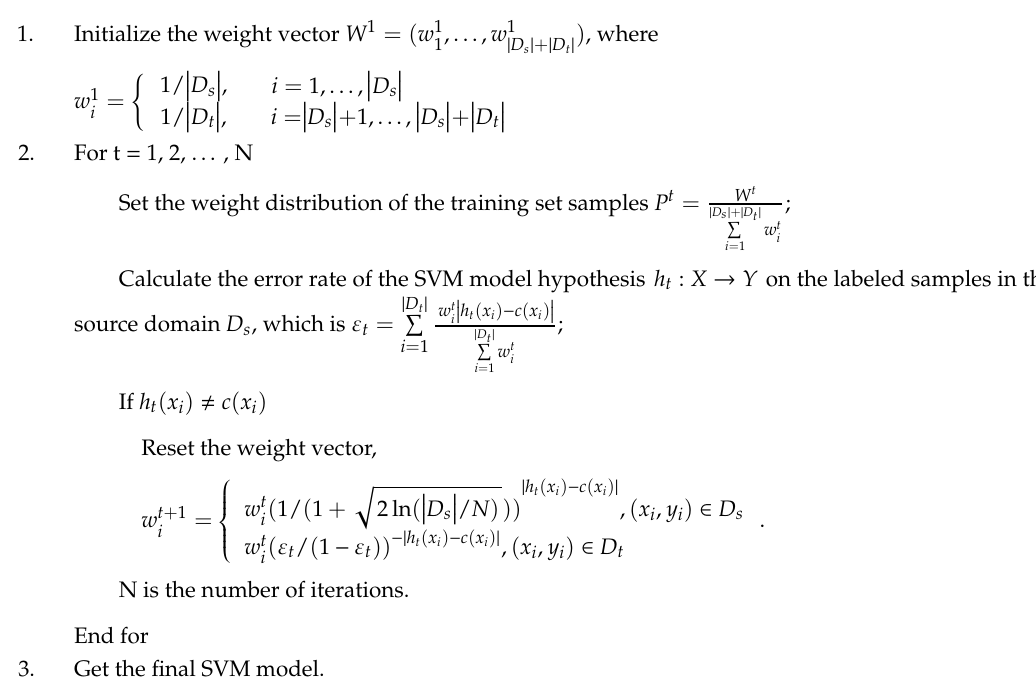
Algorithm 1. Support vector machine model based on the TrAdaBoost method